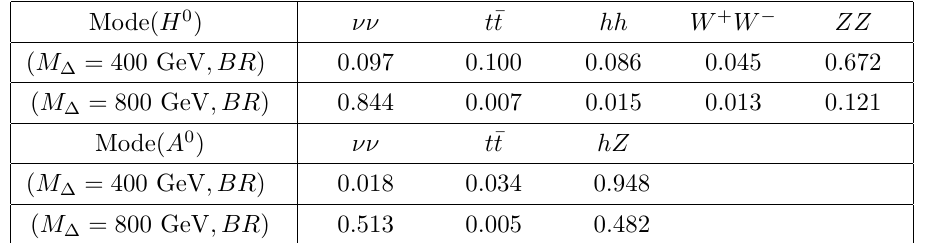
Table 4 . BRs of the H 0 and A 0 decays with (cid:21) 4 = 0, where (cid:21) 1 = 2 : 5 for M (cid:1) = 400 GeV and (cid:21) 1 = 10 for M (cid:1) = 800 GeV are